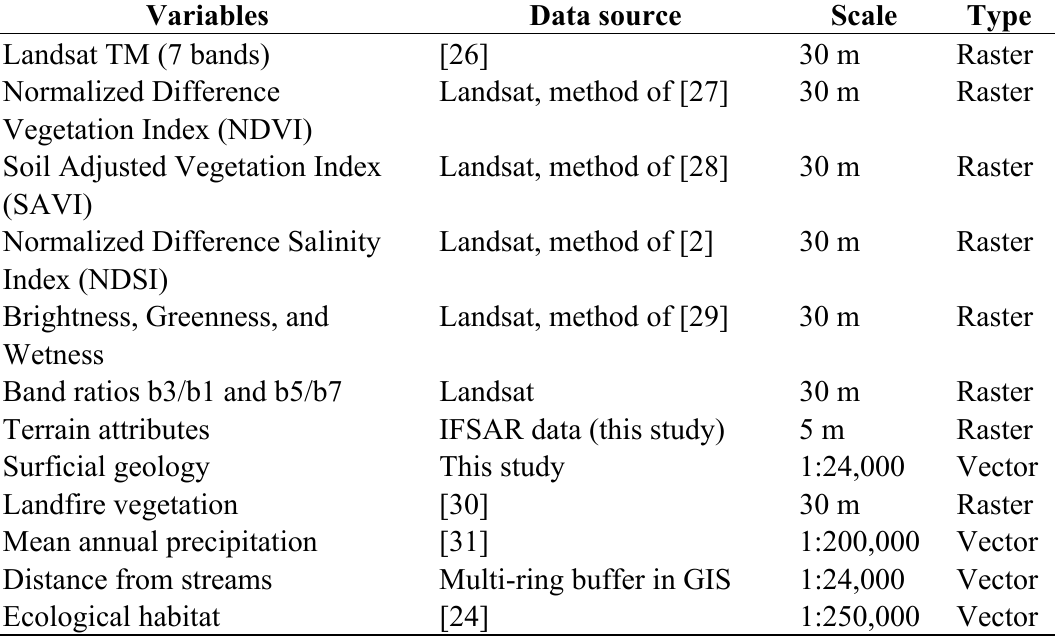
Table 1. Databases and their